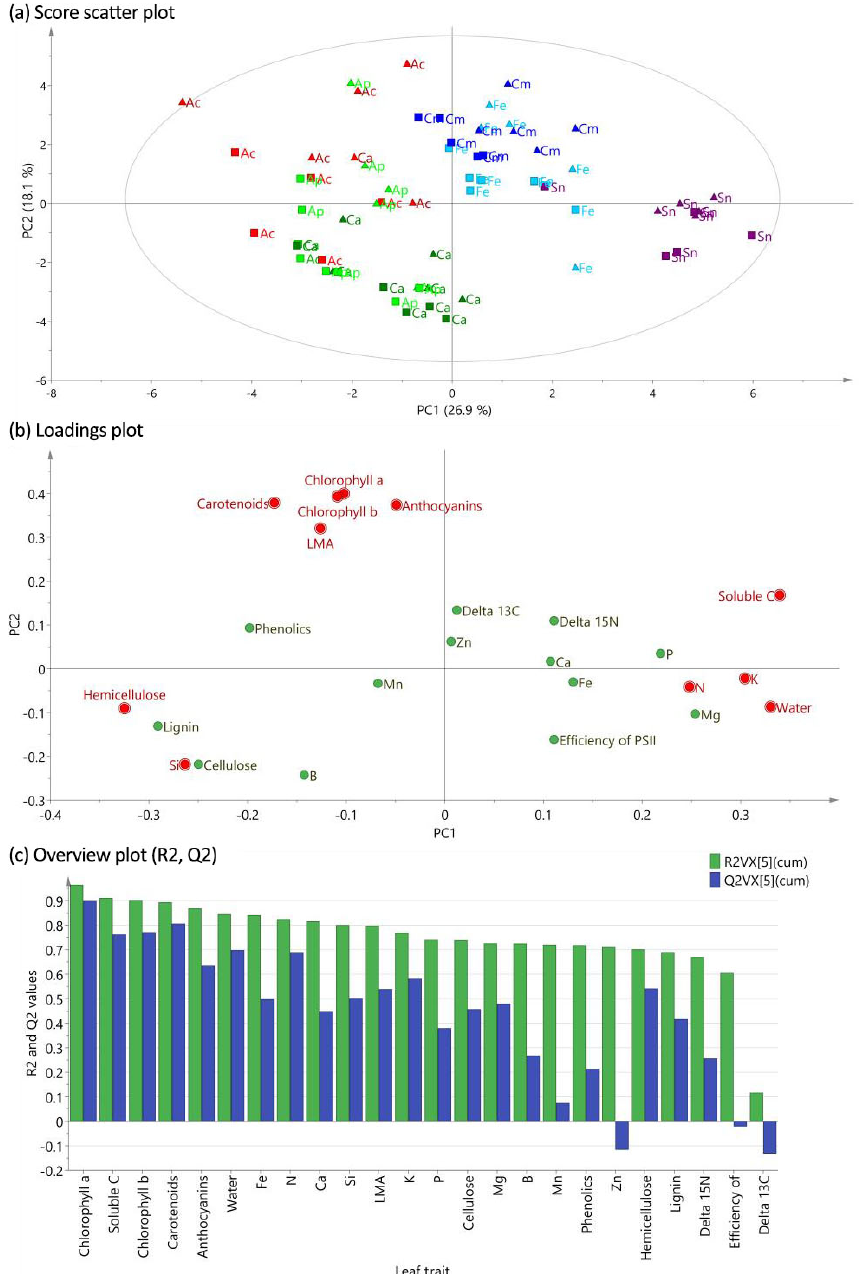
Figure 2. Principal component analysis of all leaf traits (unit variance scaled) measured across all species and sites. (a) Score scatter plot showing first and second principal components using all six species for which data exist for all 24 traits on two contrasting soil types. Colours represent species identity: Fe is Fraxinus excelsior , Sn is Sambucus nigra , Ac = Acer campestre , Cm is Crataegus monogyna , Ca is Corylus avellana , Ap is Acer pseudoplatanus . Samples from chalk sites are denoted by squares symbols and alluvium sites are denoted by triangles. (b) Loadings plot showing position and correlation of all leaf traits. Traits highlighted in red denote are those with Q 2 > 0 . 5; (c) cumulated R 2 of PCA axes 1–5 (green bars denote how well a trait can be explained in the model) and Q 2 (blue bars denote how well a trait can be predicted) values for each trait. The traits are in descending R 2 order of how well they correlate with the other traits in the data